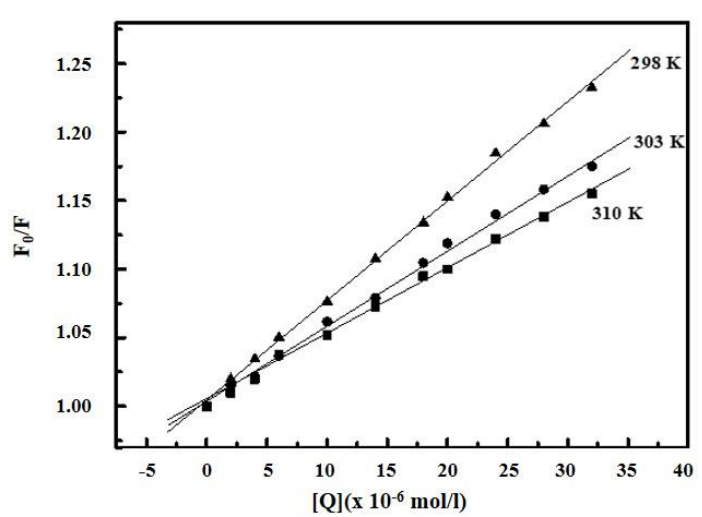
Figure 4. Stern–Volmer plots for prothioconazole (PTC) binding with bovine serum albumin (BSA) at three different temperatures .